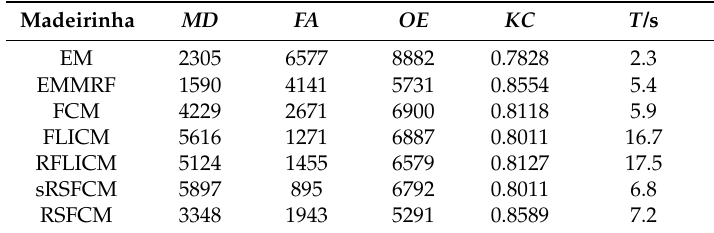
Table 5. Change detection results on Madeirinha dataset.